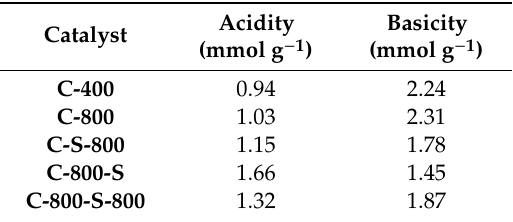
Table 2. Acid-base characterization of the